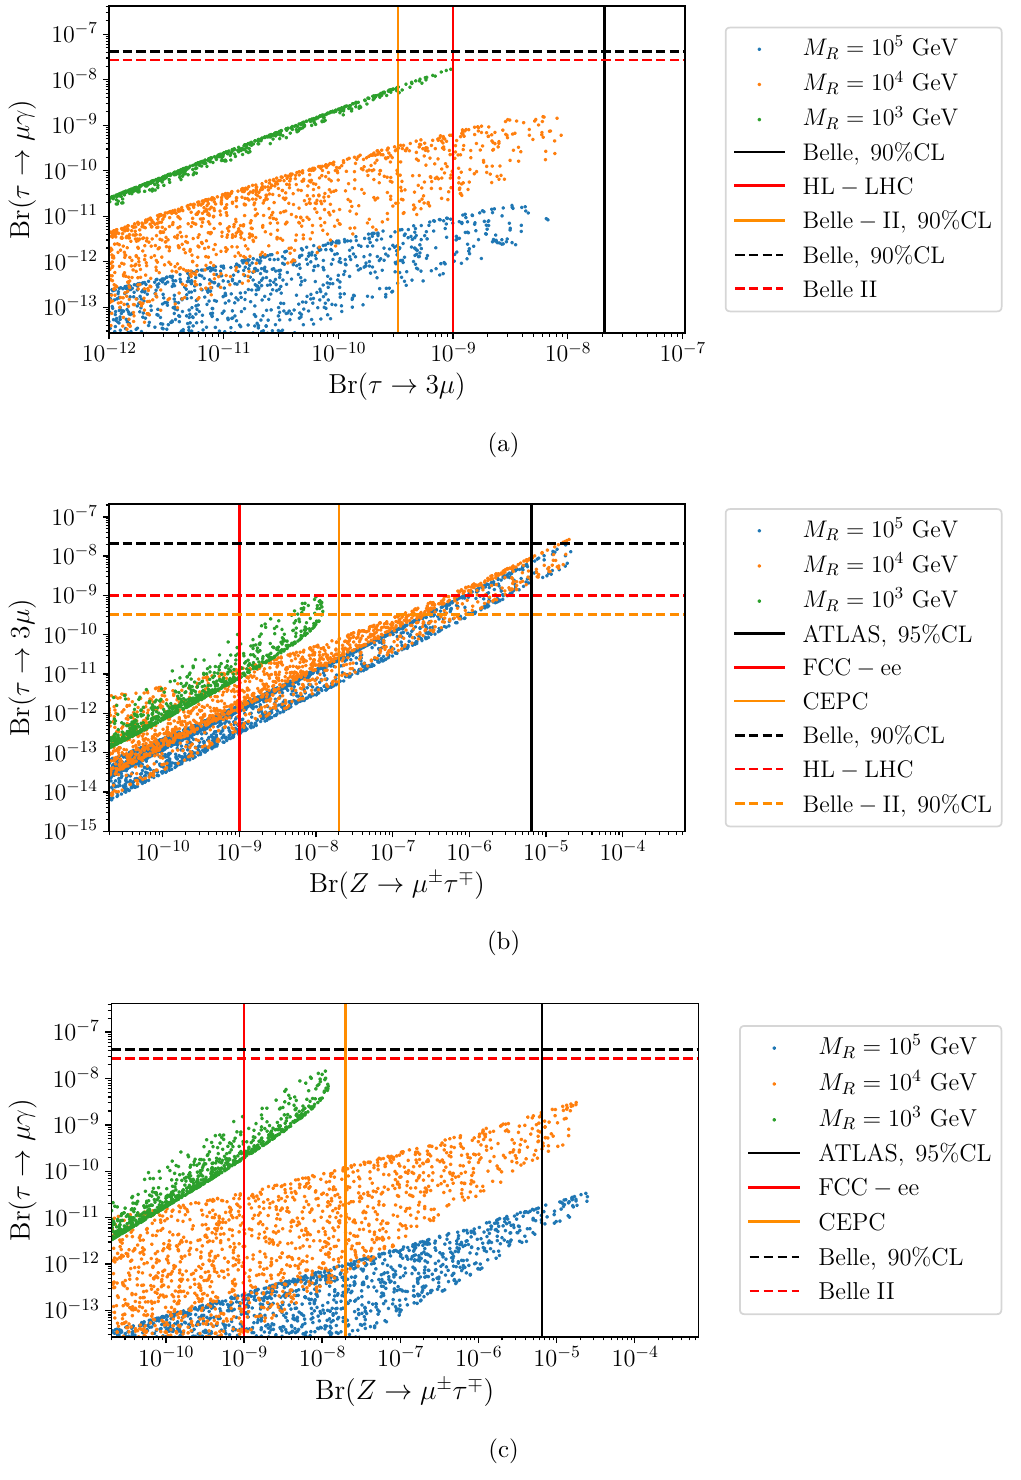
Figure 14. Correlations between the lepton flavour violating processes τ → 3 µ , τ → µγ and Z → µτ . The current experimental upper limits are indicated by the black lines while the future sensitivities are shown in red and in